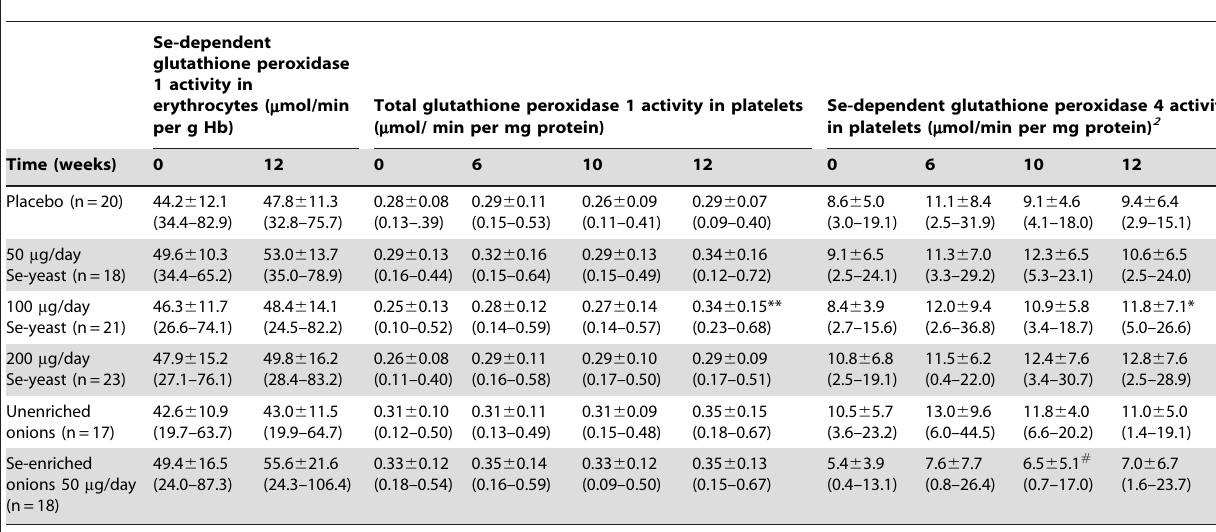
Table 2. Se-dependent glutathione peroxidase 1 activity in erythrocytes, total glutathione peroxidase 1 and Se-dependent glutathione peroxidase 4 activities in platelets: mean values at 0, 6, 10 and 12 weeks of supplementation and comparison of Se-yeast and Se-enriched onion meals with the placebo and unenriched onion groups respectively 1 .